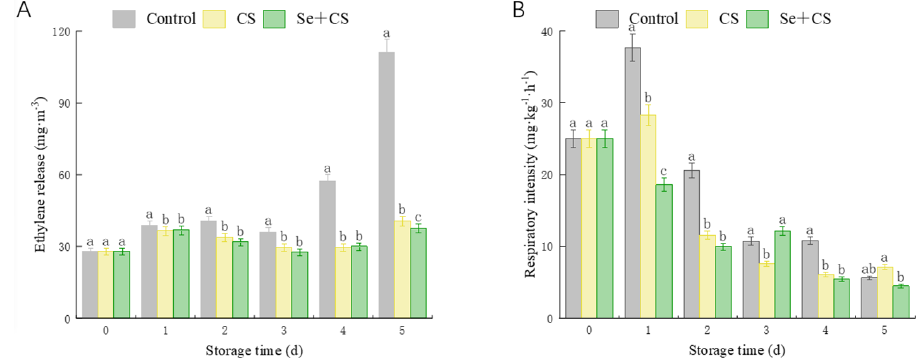
Figure 3. Ethylene production and respiration for broccoli treated with Se+CS during storage. ( A ). Ethylene production. ( B ). Respiratory intensity. Different letters represent significant differences in the same group during storage ( p < 0.05) by Duncan’s multiple range test.